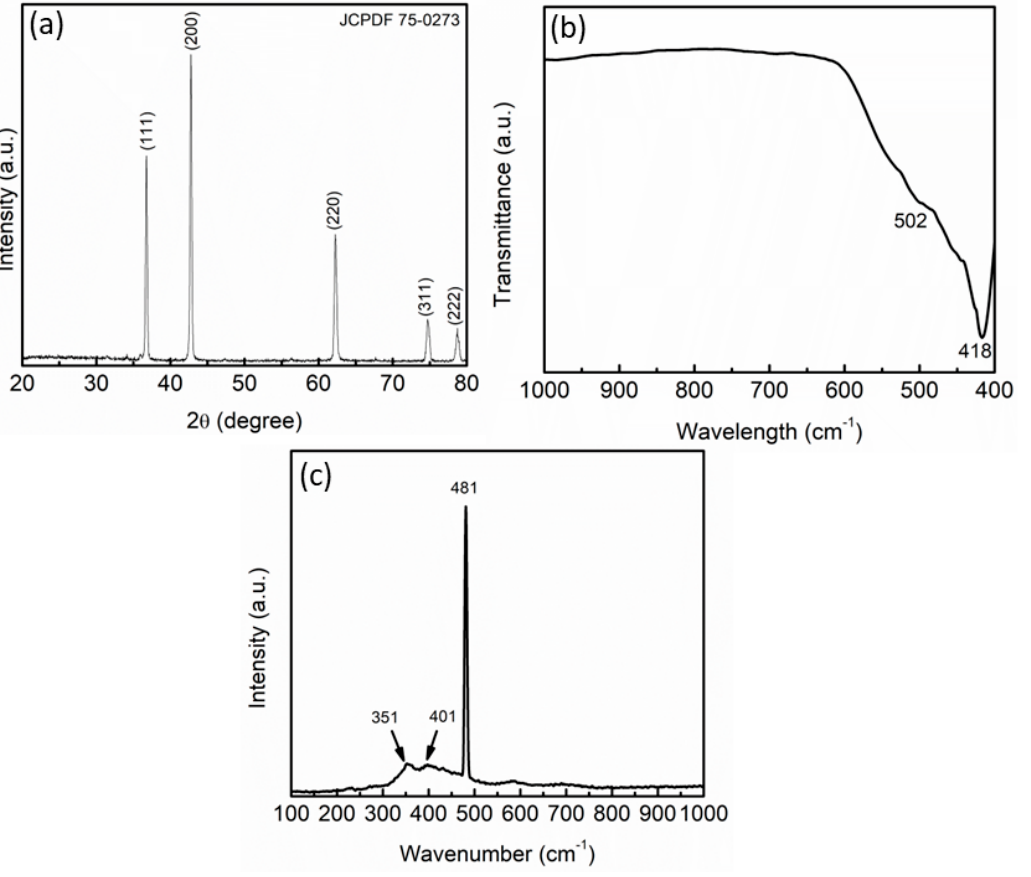
Figure 1. ( a ) XRD pattern, ( b ) FTIR spectra and ( c ) Raman spectra of Ni 0.6 Zn 0.4 O.